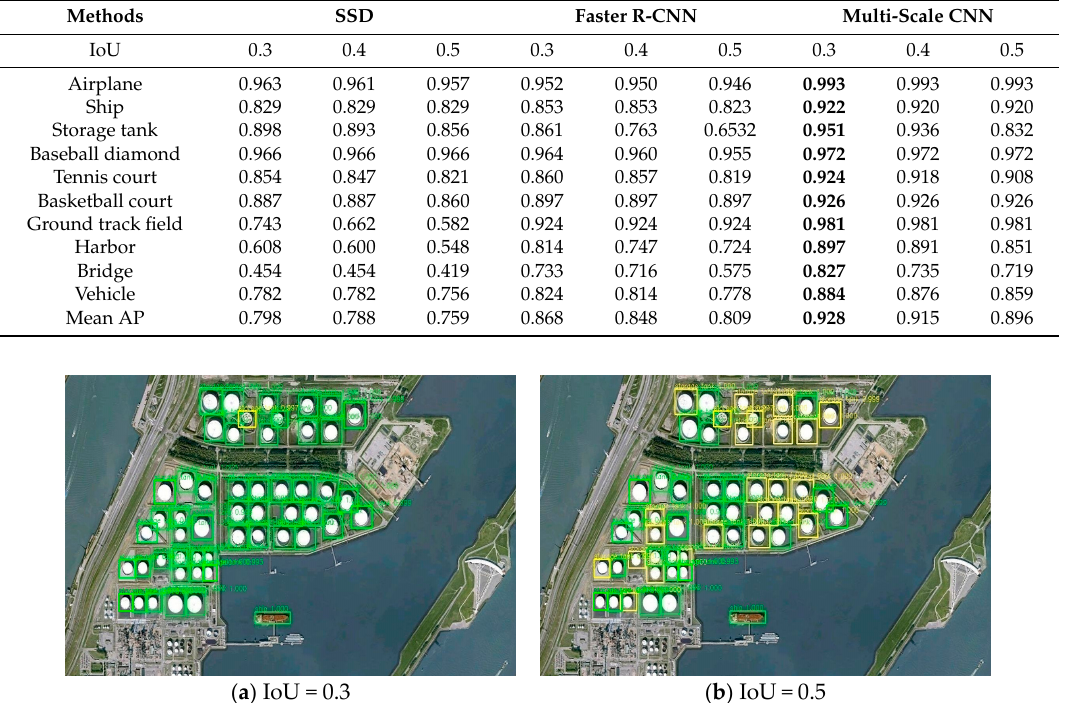
Figure 10. Detection results of storage tanks under different IoU.